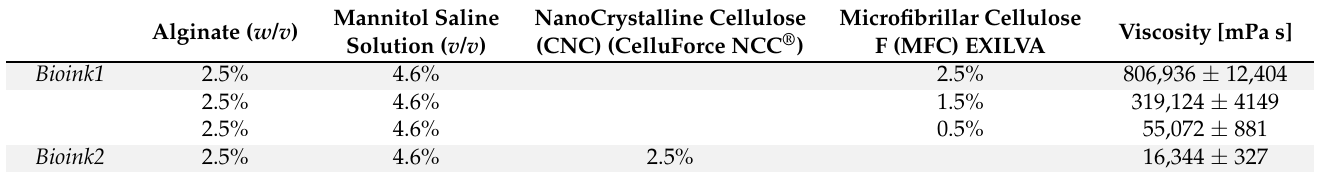
Table 1. All of the bioink formulations were stored at 4 ◦ C under sterile conditions. Table 1. Ink formulations using various cellulose